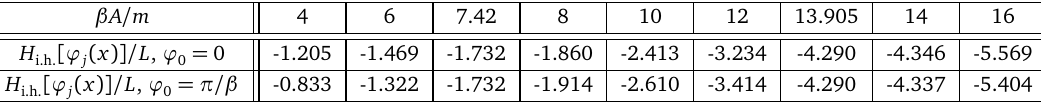
Table B.3: Energies of the two configurations ϕ m σ = 1 / 3 and (cid:96) = mL =